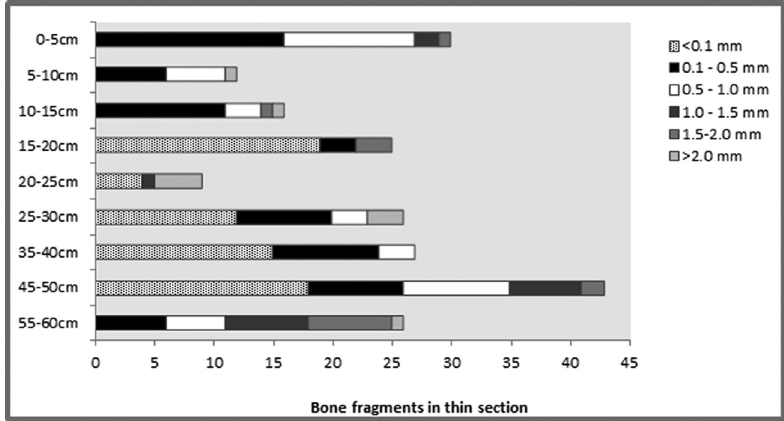
Figure 9: Summary of size distribution of bone fragments in thin sections ( unit 8932, TP Area, Level TP.Q, Çatalhöyük East )